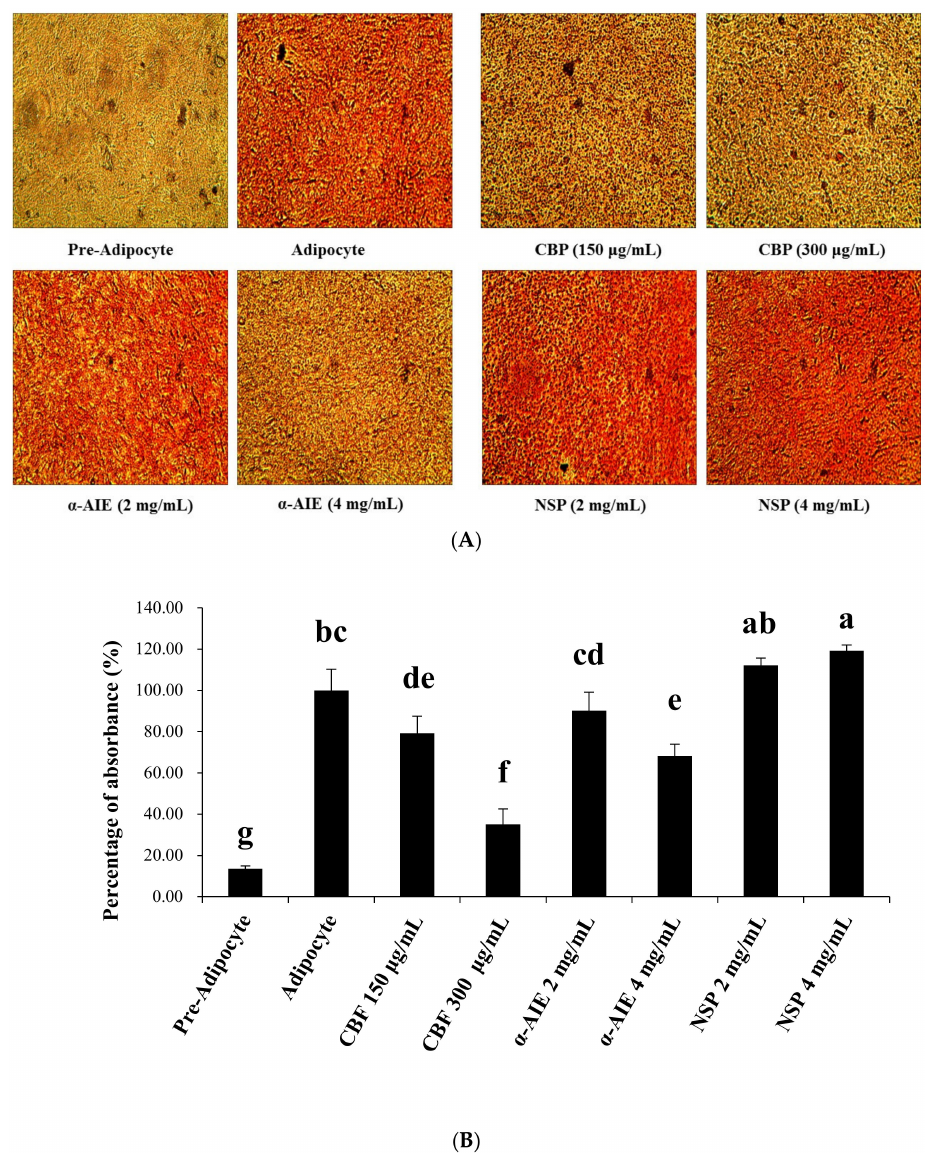
Figure 2. Effects of CBP, α -AIE, and NSP on lipid accumulation in 3T3-L1 cells. ( A ) Oil red O staining, and ( B ) Optical Density (O.D.) absorbance value. The data was expressed as mean ± SD. Different letters mean significantly difference ( p <